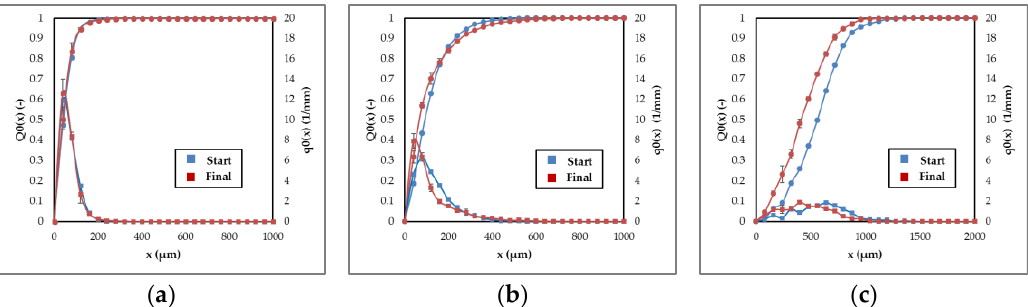
Figure 5. Agglomeration experiments of different particle fractions: ( a ) small particles, ( b ) seed particles, ( c ) large particles.